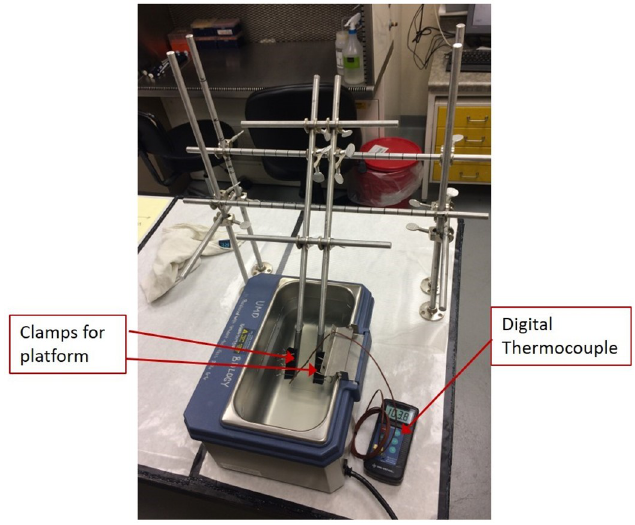
Fig 1. Experimental test setup of the steel frame in the 5L water bath. Real-time temperature is observed using the digital thermocouple. The adjustable rig is set at a platform angle of 45˚ for these